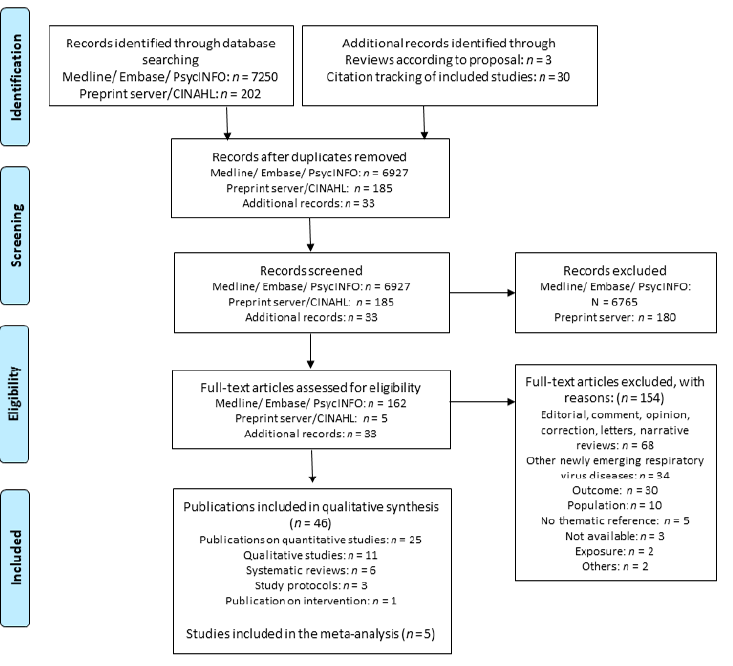
Figure 1. PRISMA flow diagram. Adapted from: Moher D, Liberati A, Tetzlaff J, Altman DG, the PRISMA Group (2009). Preferred reporting items for systematic reviews and meta-analyses: the PRISMA statement. PLoS Med 6(6): e1000097,